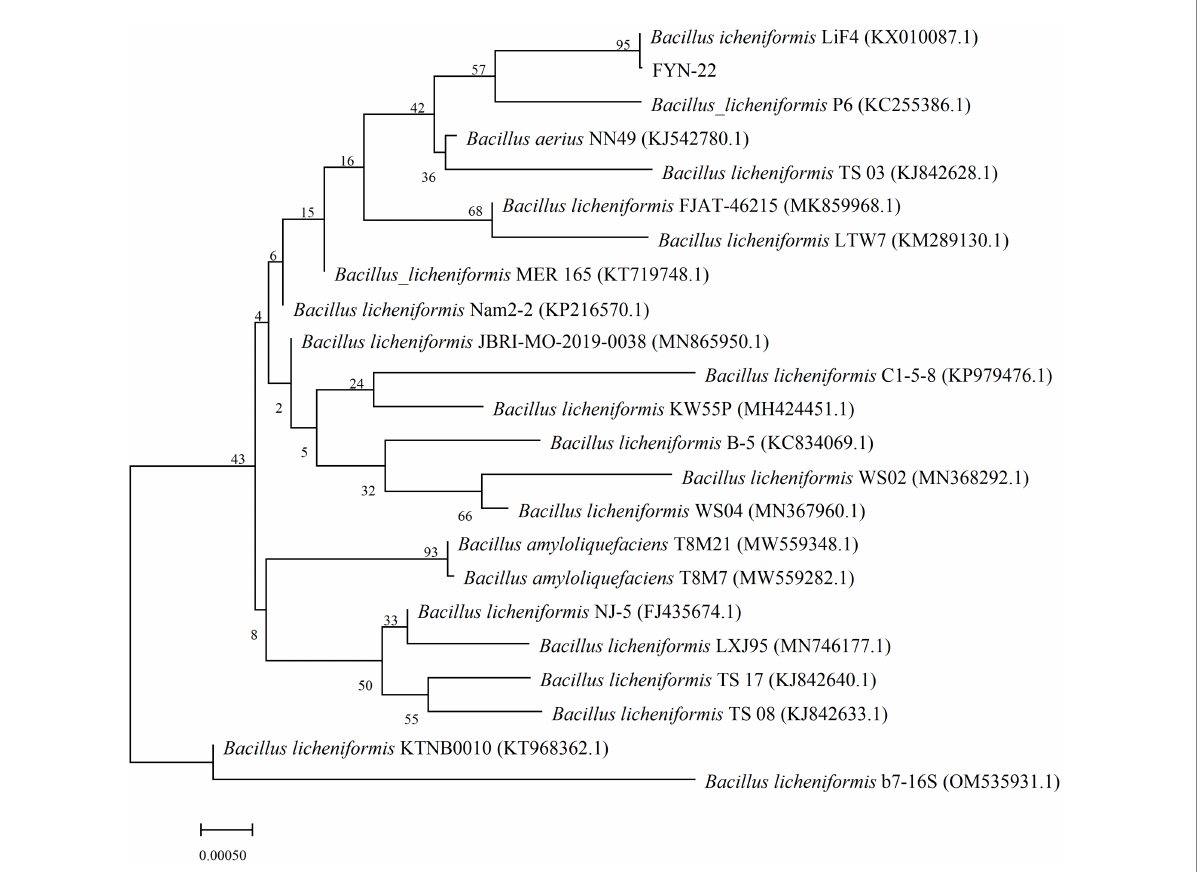
FIGURE 1 Phylogenetic tree was constructed based on the 16S rRNA sequence of the FYN-22 strain. The numbers at the nodes indicate the percentages of bootstrap sampling derived from 1,000 replications. GenBank accession numbers are given in parentheses. 0.00050 in the legend is the distance scale.